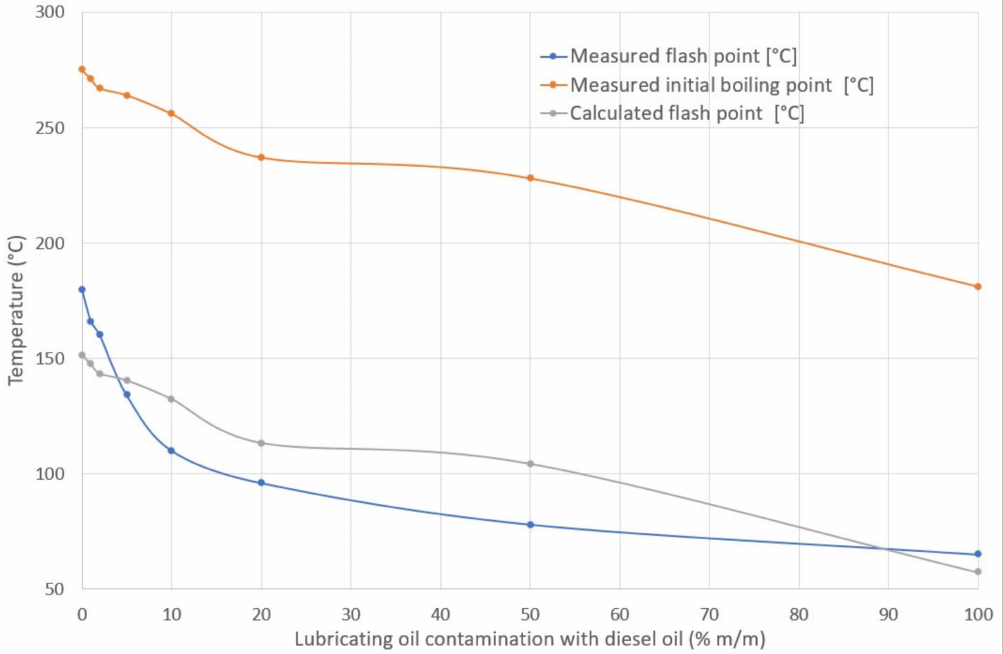
Figure 2. Measured values of the initial boiling point and the flash point and the calculated flash point of the tested SAE 30 oil at different levels of lubricating oil dilution with diesel fuel.